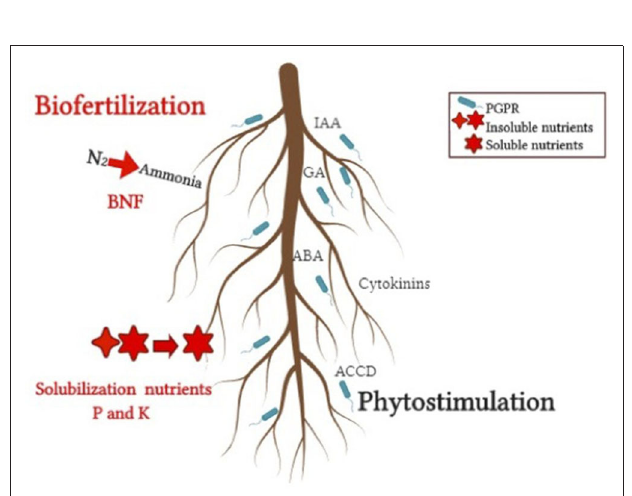
FIGURE 2 | Direct mechanisms that benefit plant growth from host-PGPR interactions. Biofertilization, nutrients solubilization, and phytostimulation.